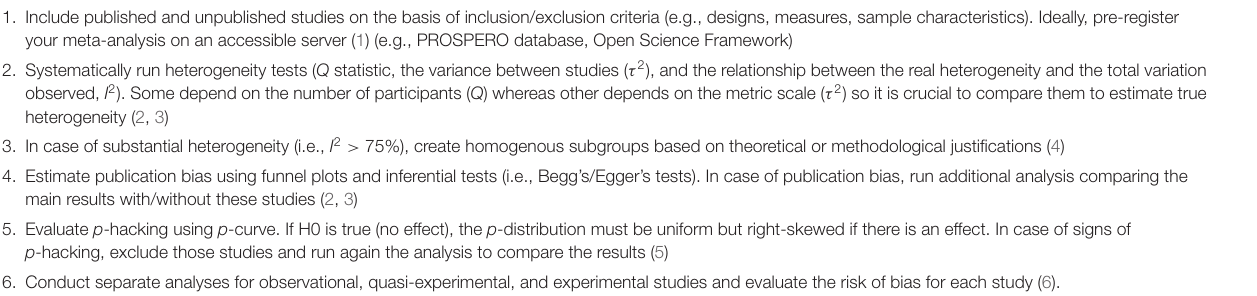
TABLE 1 | General recommendations for meta-analysis of clinical